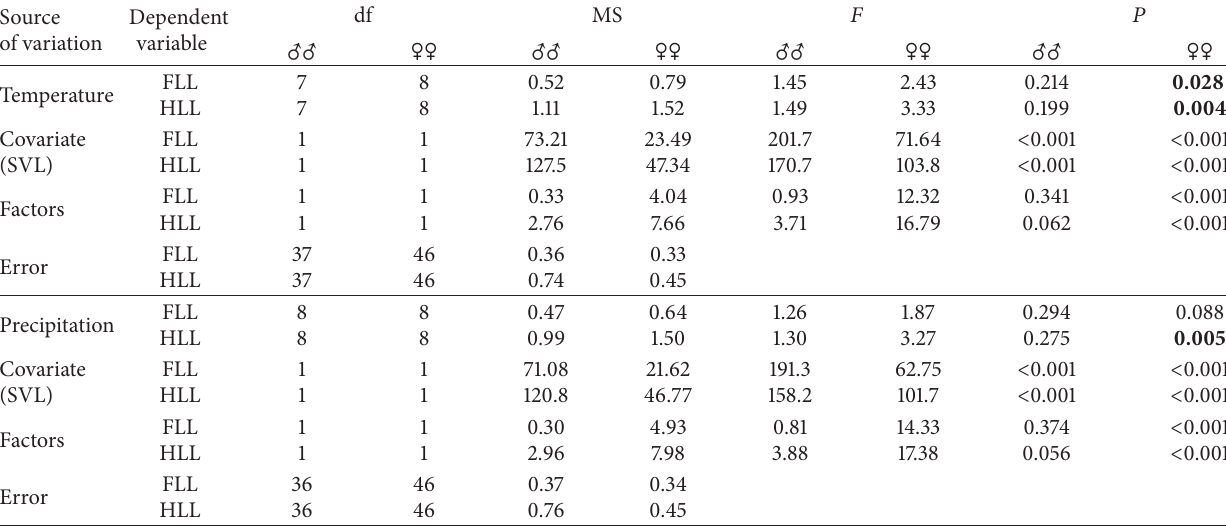
Table 3: Results of a MANCOVA examining the effect of temperature and precipitation on total fore limb length (FLL) and total hind limb length (HLL) in Phoenicolacerta laevis with SVL as a covariate. Significant effects are marked in bold letter.